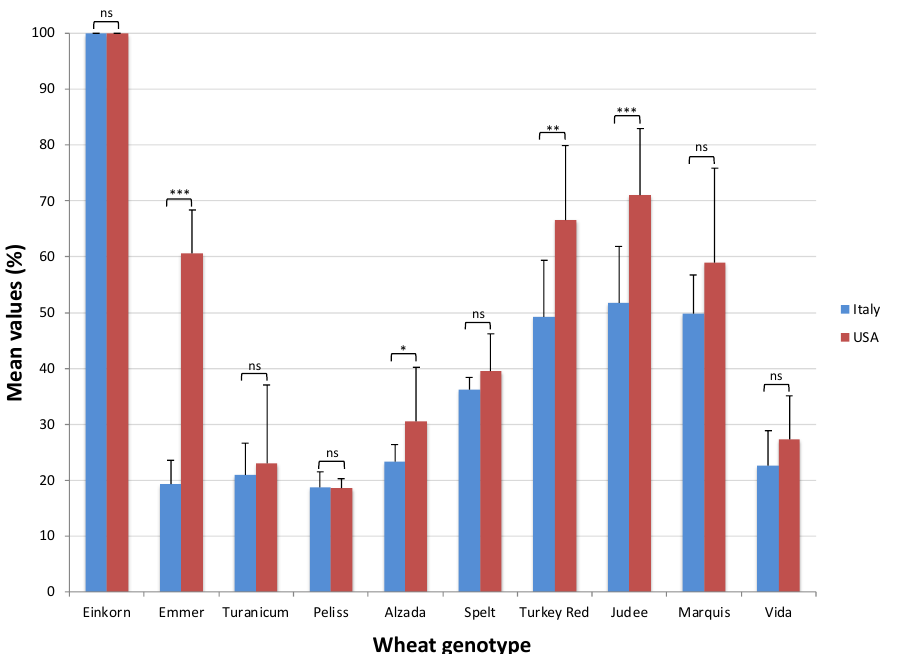
Figure 5. Differences between the mean values of trypsin inhibitory activity in the USA and in Italy for each wheat genotype. Significance level: * p < 0.05; ** p < 0.01; *** p < 0.001. ns, not significant.